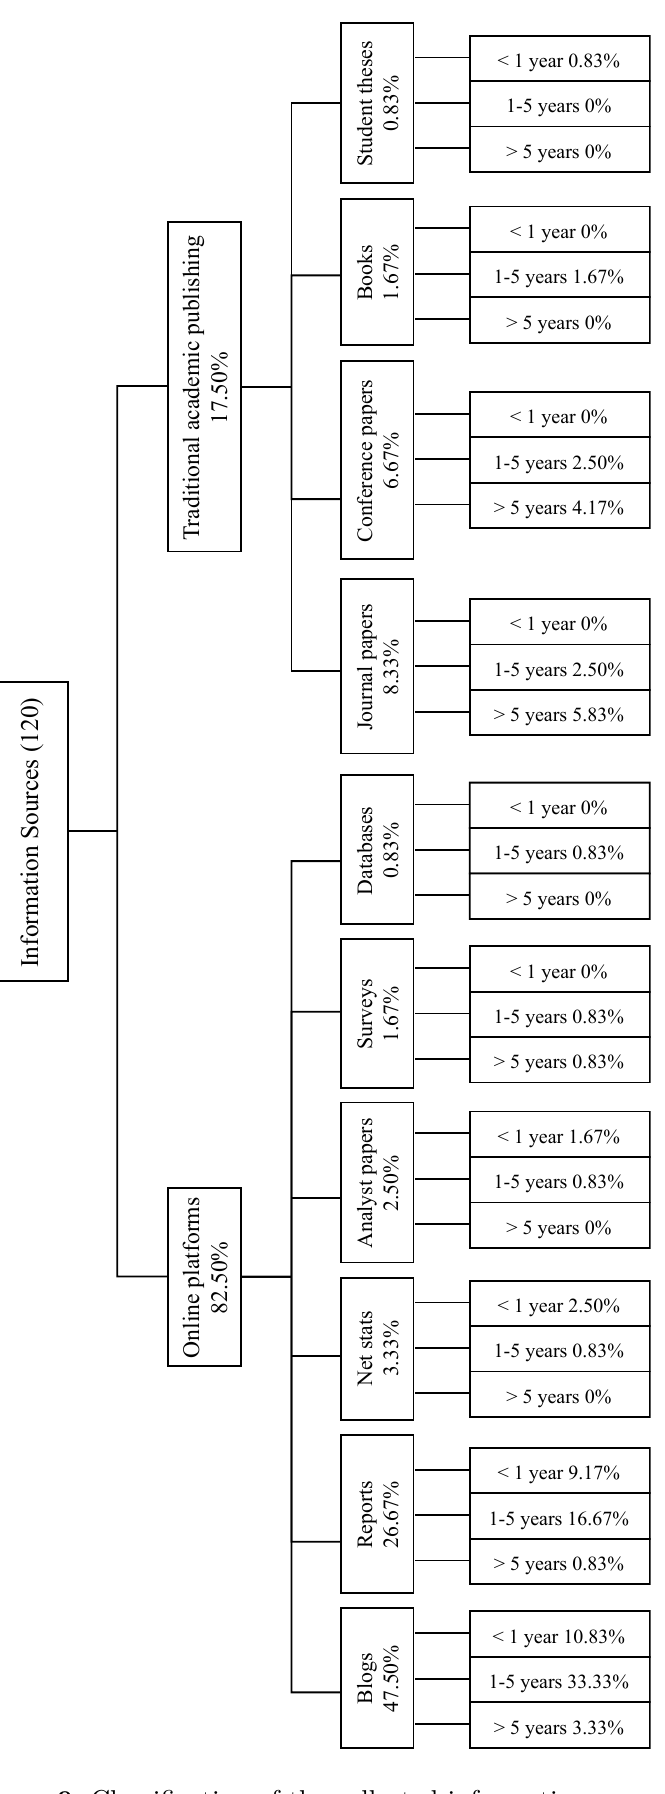
Figure 9. Classification of the collected information